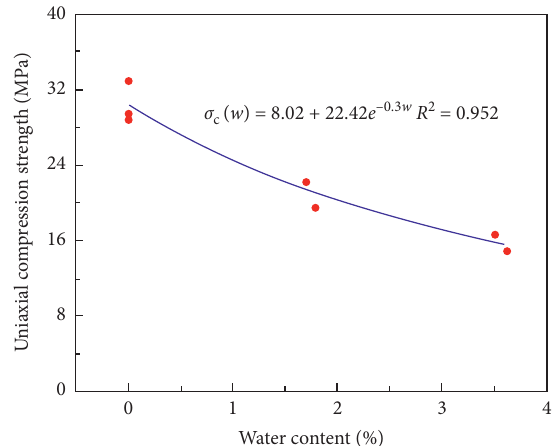
Figure 5: The relation between uniaxial compressive strength and water content.